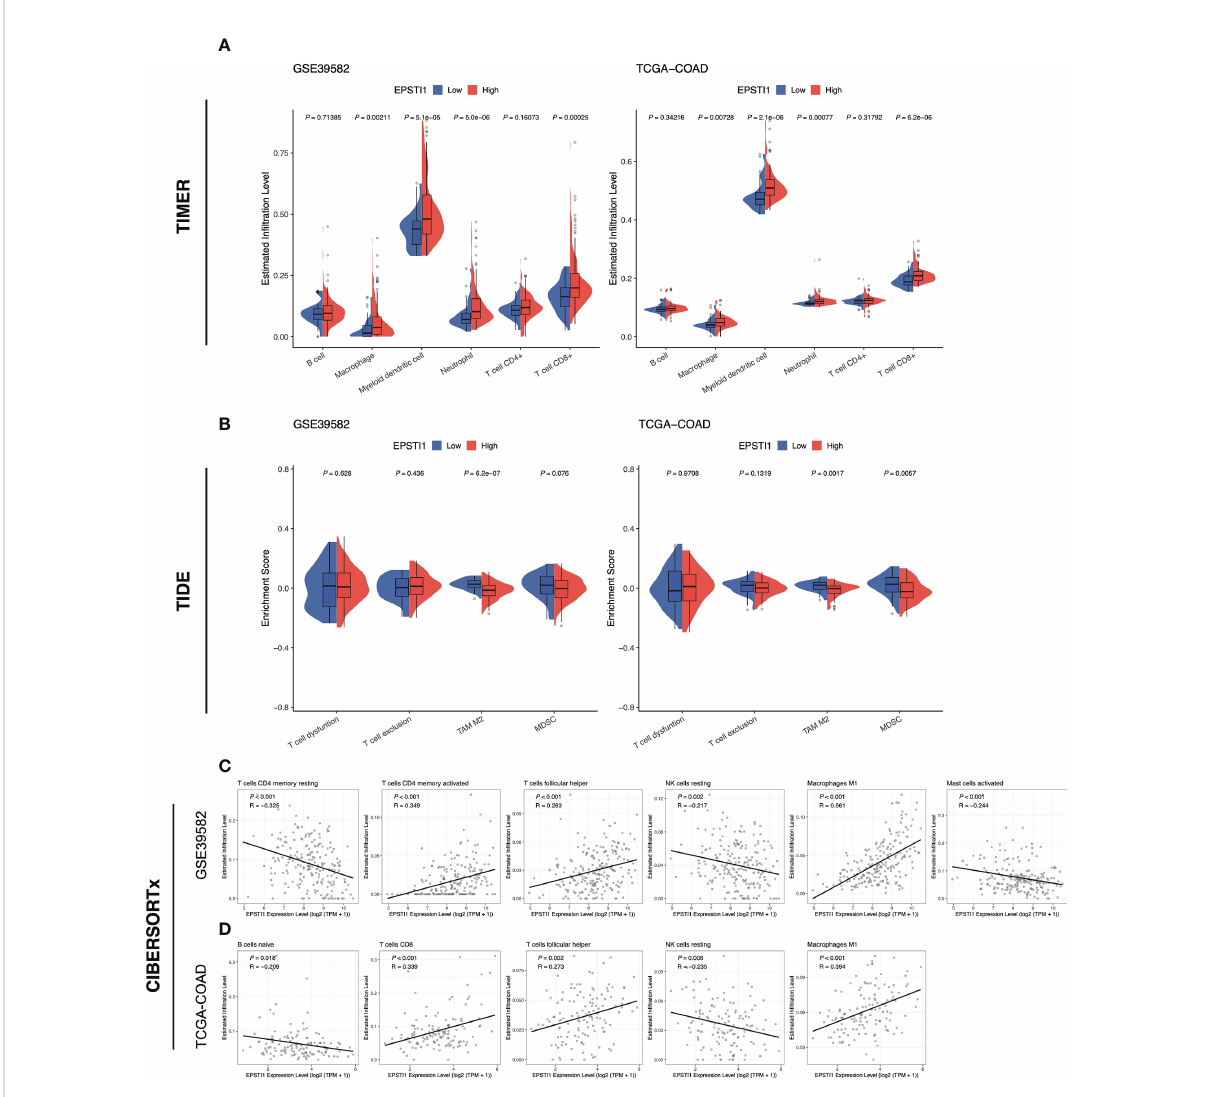
FIGURE 5 The association between EPSTI1 expression level and immune cell in fi ltration. (A) Comparison of immune cell in fi ltration in the high and low EPSTI1 groups estimated with the TIMER algorithm in the GSE39582 and TCGA-COAD cohorts. TIMER, Tumor Immune Estimation Resource. (B) Enrichment scores of immunosuppressive cell signatures estimated by the TIDE algorithm. TIDE, Tumor Immune Dysfunction and Exclusion. (C, D) Scatter plots of EPSTI1 expression and immune cell in fi ltration levels, which were estimated by the CIBERSORTx algorithm. The Pearson ’ s correlation coef fi cient (R) and corresponding P-value are shown at the left top of each